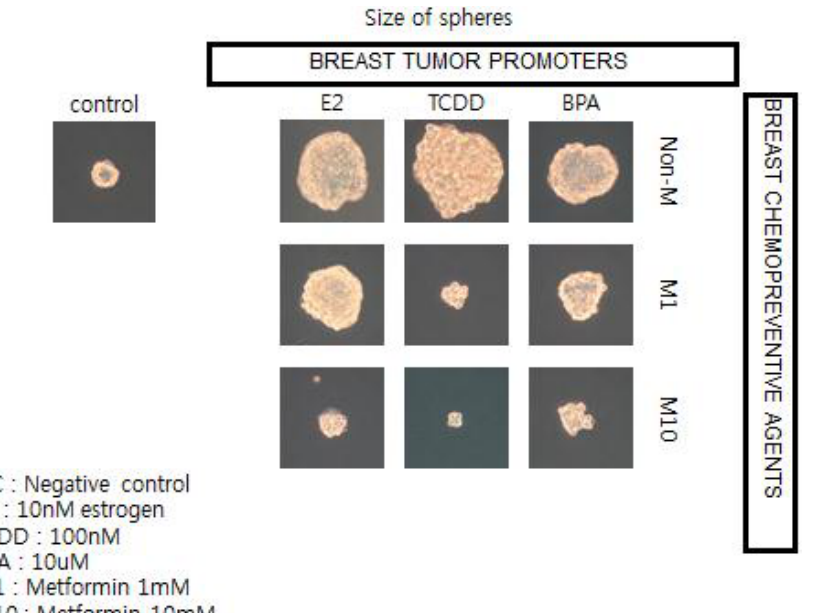
Figure 12. This figure illustrates MCF-7 human breast carcinomas cells expressing the estrogen receptor and forming mammospheres after exposure to a solvent, estrogen (E2), the epigenetic tumor promoter TCDD, and the epigenetic toxicant bisphenol A, with or without exposure to metformin (BPA). It is clear that E2, TCDD, and BPA cause enhanced growth of the mammospheres compared to the control mammospheres, while co-treatment with two concentrations of non-cytotoxic metformin significantly inhibited the growth stimulation of E2, TCDD, and BPA. Permission granted from PLOS ONE. In: Jung, J.-W., et al.